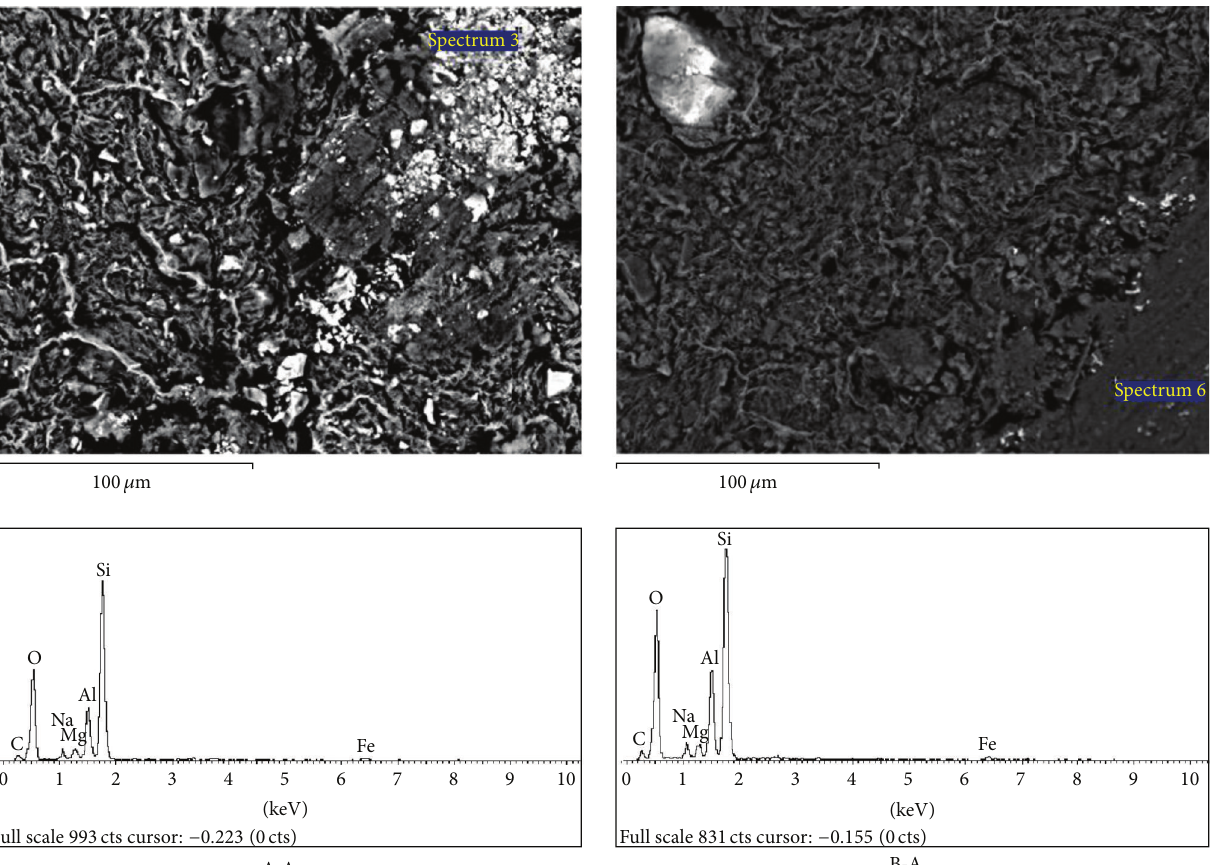
Figure 4: SEM-EDS images of the bentonite particles (A-A and B-A) hydrated with distilled